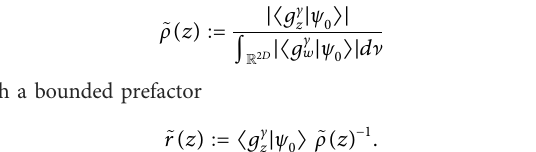
Algorithm 1: (Herman – Kluk